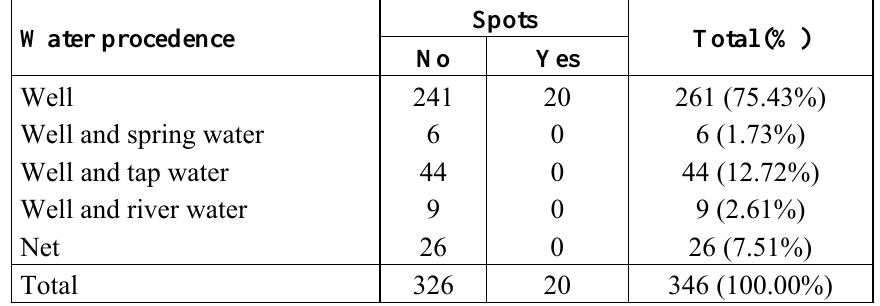
Table 3. Numbers of subjects according to extrinsic enamel stain occurrence in accordance with the source of the water, Caapiranga, AM, Brazil, 2011.